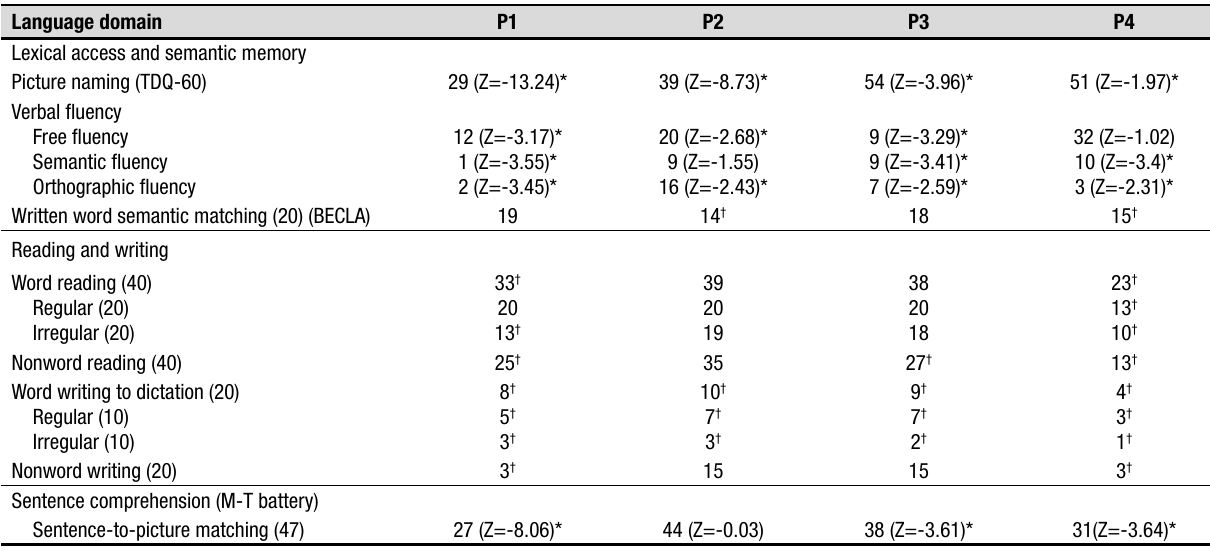
Table 2. Participants’ results on language